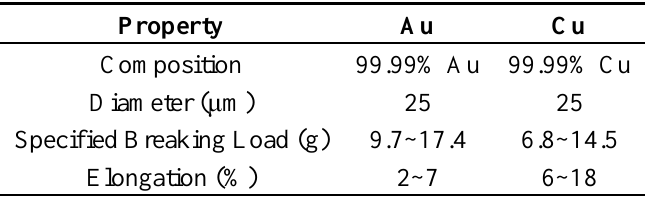
Table 1. Material properties of Au and Cu wires.